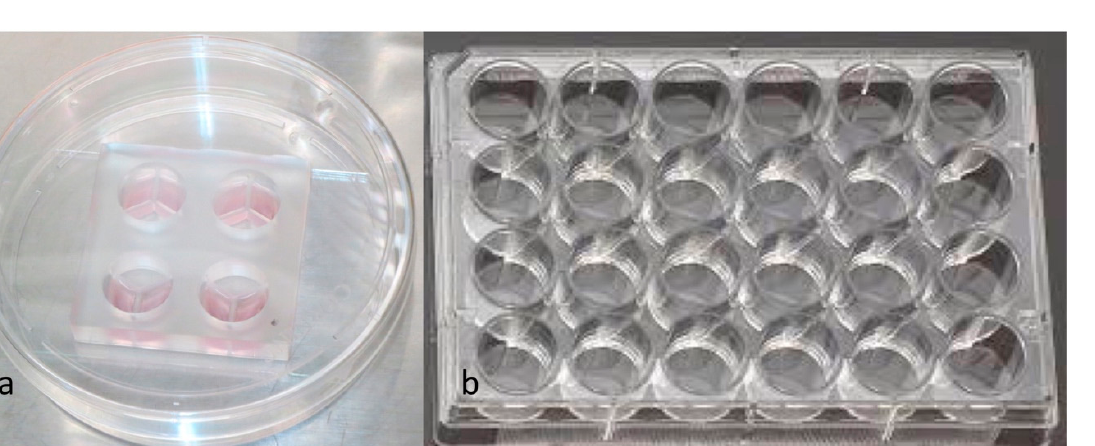
Figure 5. The idea of platelet-derived cytokines diffusion in the 3-chamber co-culture system. ( a ) 40 μ L PRP and 40 μ L culture medium were added to one sub-chambers of the co-culture device. ( b ) Then, 100 μ L culture medium were added to each of the other two sub-chambers. ( c ) After gelling of the PRP overnight, 700 μ L culture medium was added to the whole culture well to cause the culture medium to cross the central barrier. ( d ) The platelet-derived cytokines released in the medium would diffuse to all 3 sub-chambers.